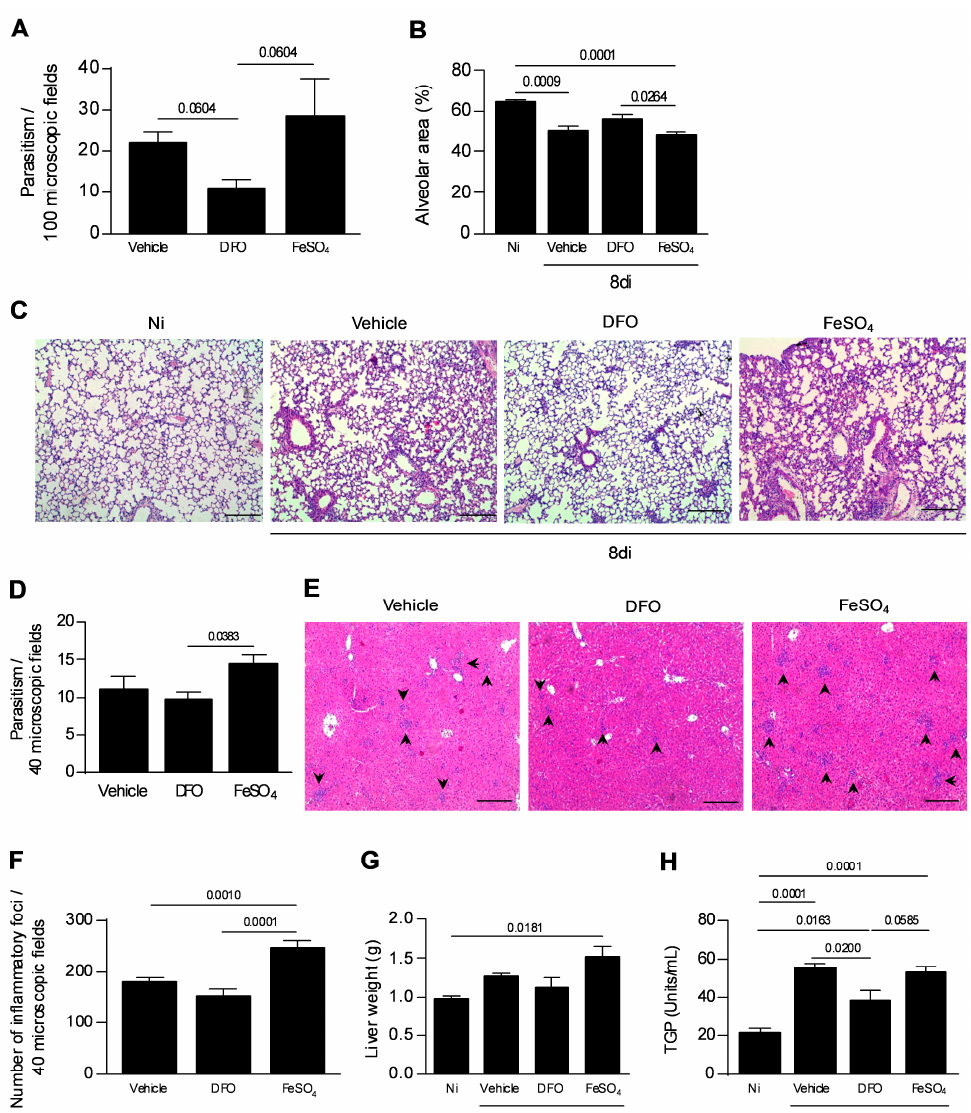
Figure 5. Tissue parasitism and inflammatory alterations in the lung and liver of T. gondii -infected mice treated with an iron chelator or iron supplemented. C57BL / 6 mice were orally infected with 20 cysts of the T. gondii ME-49 strain and treated with vehicle (PBS) or 300 mg / kg of deferoxamine (DFO) or 100 mg / kg of ferrous sulfate heptahydrate (FeSO 4 ) by intraperitoneal (i.p.) route one day before infection, and for an additional seven days after infection. The parasitism was quantified in 100 microscopic fields ( A ). The measurement of the alveolar area in 10 microscopic fields ( B ). Representative photomicrographs of pulmonary tissues ( C ). Tissue parasitism in the liver in 40 microscopic fields ( D ). Quantification of inflammatory foci in the liver in 40 microscopic fields ( E ). Representative photomicrographs of the inflammatory foci in the liver ( F ). The arrows indicate the inflammatory foci. Liver weight ( G ). Serum levels of pyruvic transaminase (TGP) ( H ). Non-infected (Ni); days of infection (di). Data were analyzed by Kruskal Wallis followed by Dunn’s post-test ( A , H ) and one-way ANOVA followed by Sidak’s post-test ( B , G , H ). Scale bar = 50 µ